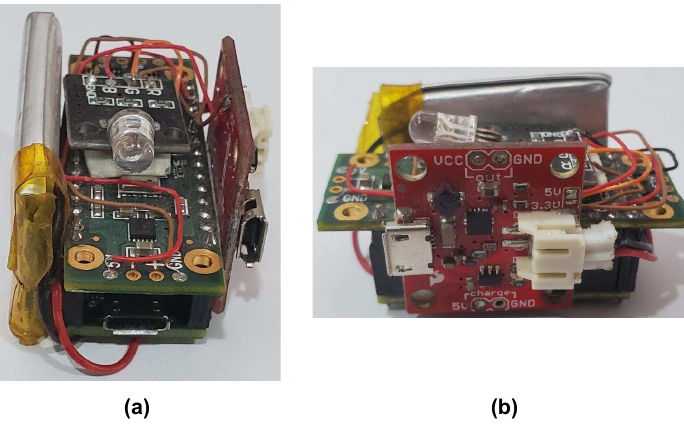
Figure 5. Illustration of the test bench used for the data capture. ( a ) Teensy 3.2 board and Prop Shield sensor board; ( b ) lithium-battery charger